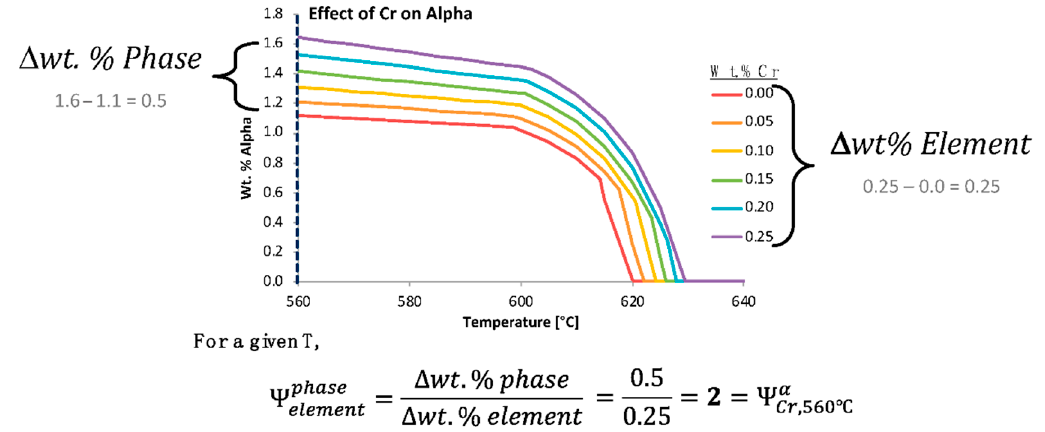
Figure 8. Variation in the prediction of the equilibrium alpha phase in Al 6061 with a content variation of chromium according to the legend provided. The vertically dashed line superimposed upon the wt.% alpha versus temperature curves was included to signify a temperature of 560 °C that was associated with the embedded demonstration of 𝜓 computation. Materials 2020 , 13 , x FOR PEER REVIEW 16 of 34